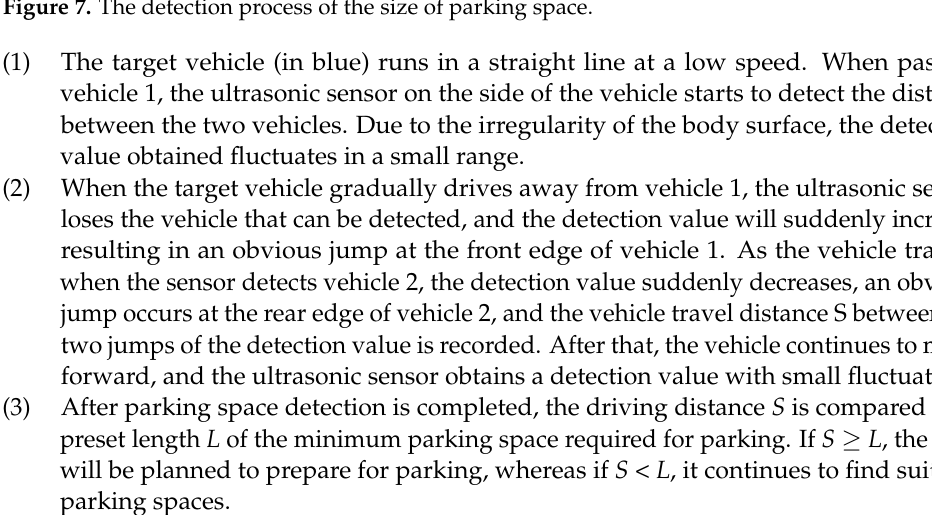
Figure 7. The detection process of the size of parking space.